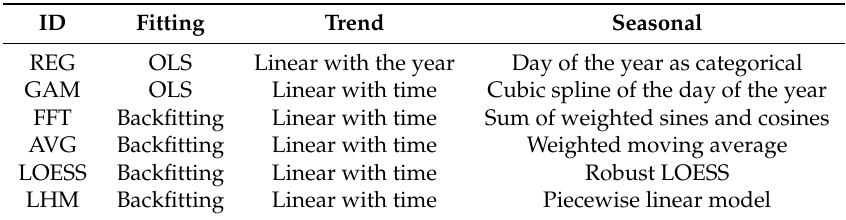
Table 1. List of models and main